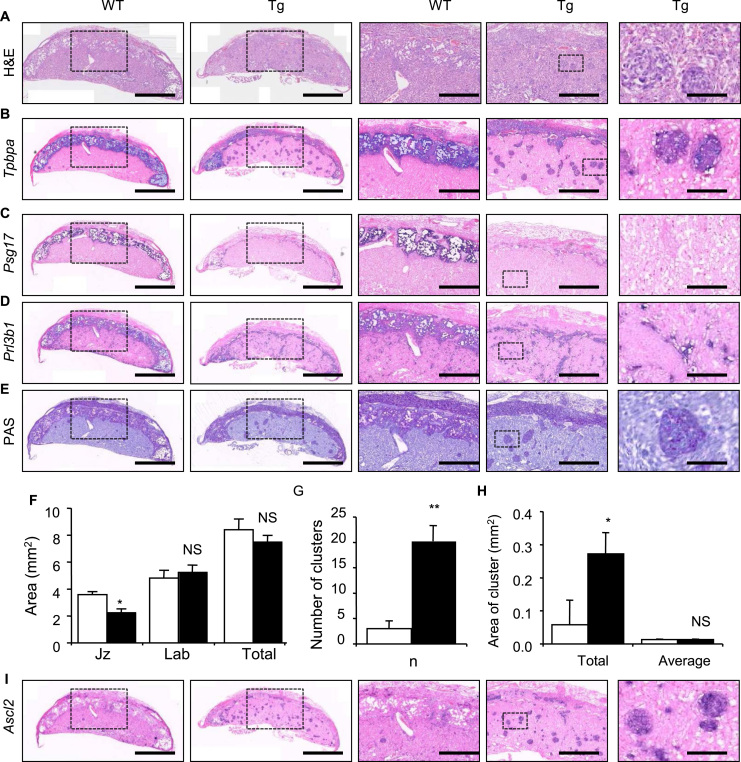
A substantial loss of the spongiotrophoblast and mislocalisation of glycogen cells at E14.5. (A) H+E staining at E14.5 illustrating loss of the junctional zone. (B) In situ hybridisation with a Tpbpa riboprobe, which specifically marks the spongiotrophoblast and glycogen cell lineages in the junctional zone, at E14.5. (C) In situ hybridisation with a Psg17 riboprobe, which is expressed in just the spongiotrophoblast at E14.5. (D) In situ hybridisation with a Prl3b1 riboprobe, which is expressed in the P-TGC, C-TGC, S-TGC and the spongiotrophoblast at E14.5, showing a degraded interface between the junctional zone and maternal decidua. (E) PAS staining of glycogen cells in the junctional zone at E14.5. Three right hand images highlighting mislocalisation of glycogen cells in the labyrinth. (F) Midline section areas (mm2) occupied by the junctional zone and labyrinth, and total area of both at E14.5. (G) Number of Tpbpa+ve/Psg17−ve/Prl3b1−ve/PAS+ve/Ascl2+ve clusters present in the labyrinth. (H) Total and average area (mm2) occupied by Tpbpa+ve/Psg17−ve/Prl3b1−ve/PAS+ve/Ascl2+ve clusters in the labyrinth. (I) In situ hybridisation with an Ascl2 riboprobe, demonstrating mislocalised cells express Ascl2. Scale bars=1000 µm (two images on left); 350 µm (middle and adjacent right image) and 150 µm (far right image).